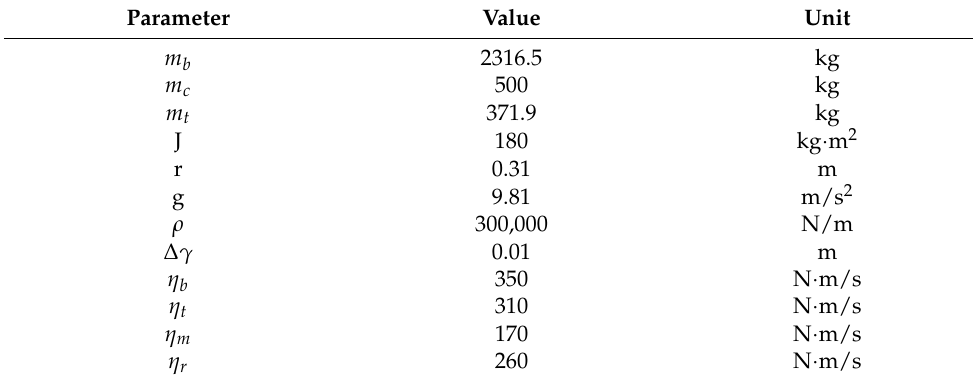
Table 2. The parameters of the 3D overhead crane.